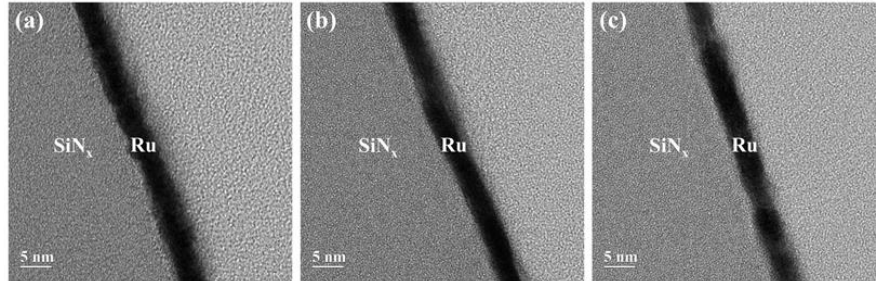
Figure 4. Cross-sectional TEM images of the Ru/SiN x pellicle composites: ( a ) as deposited, ( b ) after annealing at 300 °C, and ( c ) after annealing at 500 °C .